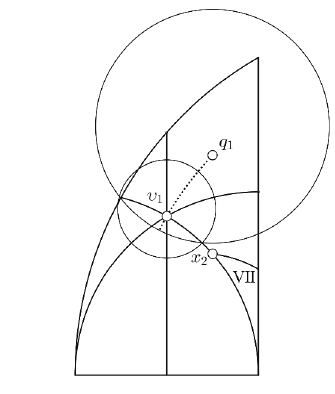
Figure 11. Number ε > 0 is chosen now in such a way that every circle with centre q 1 does not overlap region VII . Circle with center at q 1 and radious d ( q ,v ε is included in the union of regions I , II and IV along with a small circle with center at v 1 1 ) +